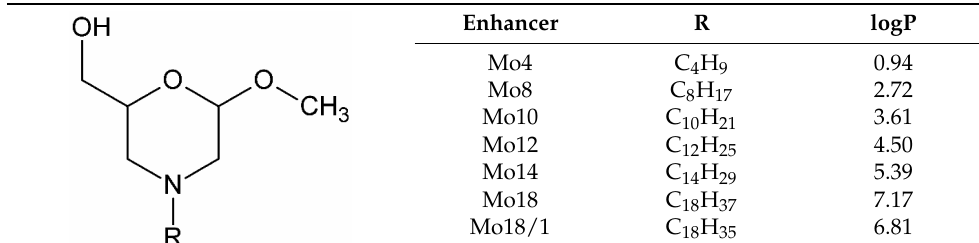
Table 1. The structure of the studied morpholine derivatives and their calculated logP values, R = alkyl chain, 18/1 indicates the double bond in position